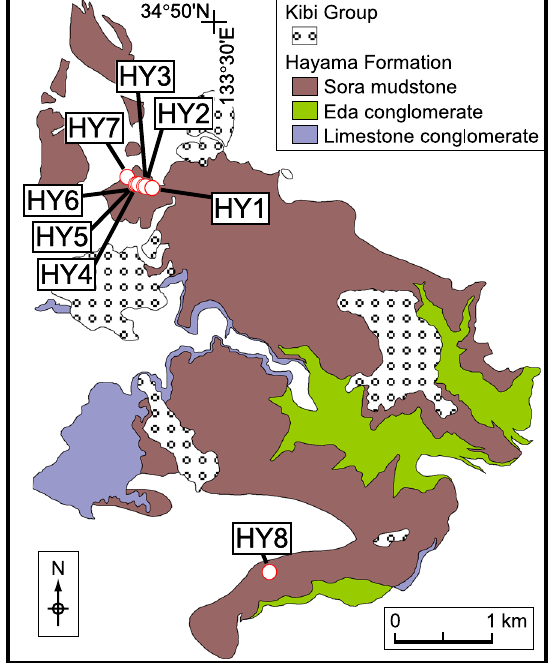
Fig. 2 Geological map of the Hayama Formation in the Hayama area (Suzuki et al. 2001). Open circles denote the paleomagnetic sampling